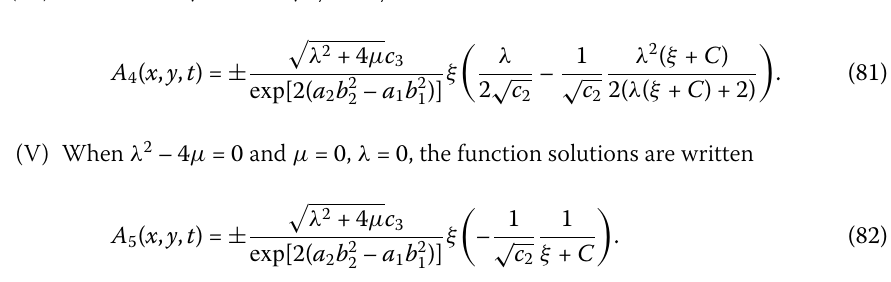
(IV) When λ 2 – 4 μ = 0 and μ (cid:12) = 0 , λ (cid:12) = 0 , the rational function solutions are